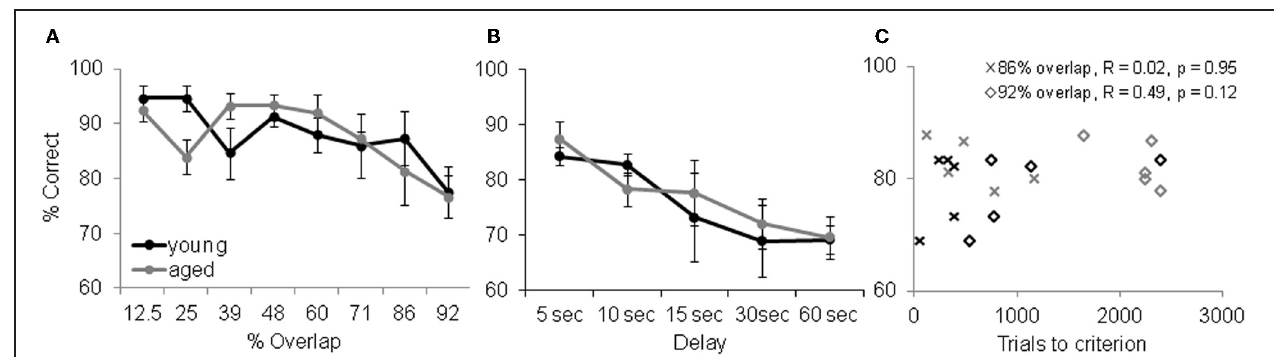
(Y-axis) across the different levels of feature overlap (X-axis). There was a significant exponential relationship between percent overlap and trials to criterion in both the young and the aged monkeys. Relative to the young animals, the aged monkeys required significantly more trials to reach criterion on the 86% and 92% overlap conditions. Error bars represent ± 1 standard error of the mean (reprinted with permission Burke et al., 2011).